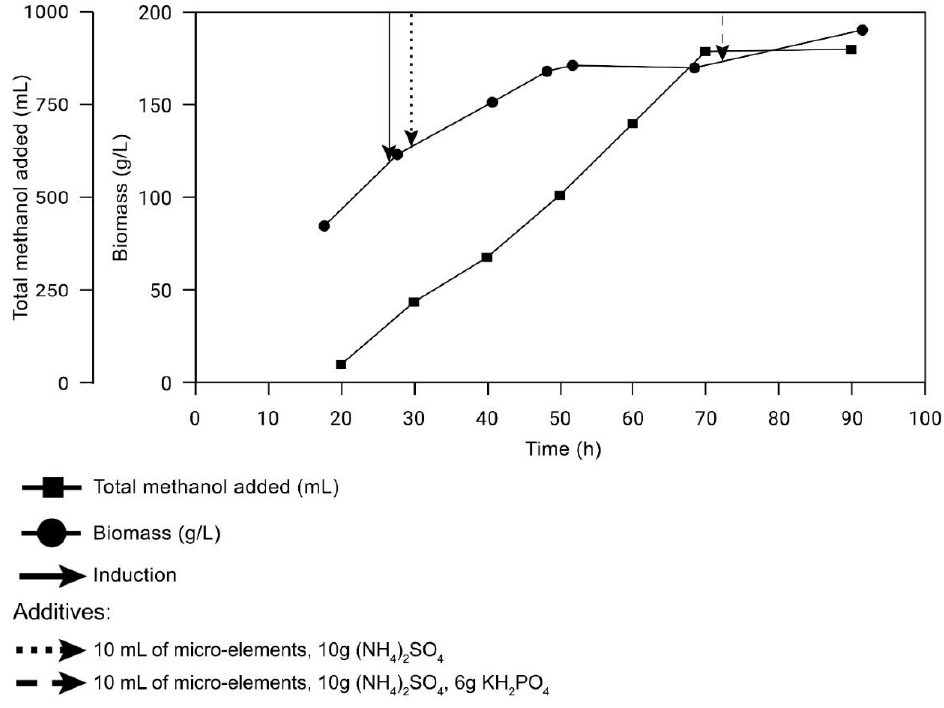
Figure 4. Mass-spectrometry MS1 analysis (verified amino acids of xAor are highlighted red) (Pro-